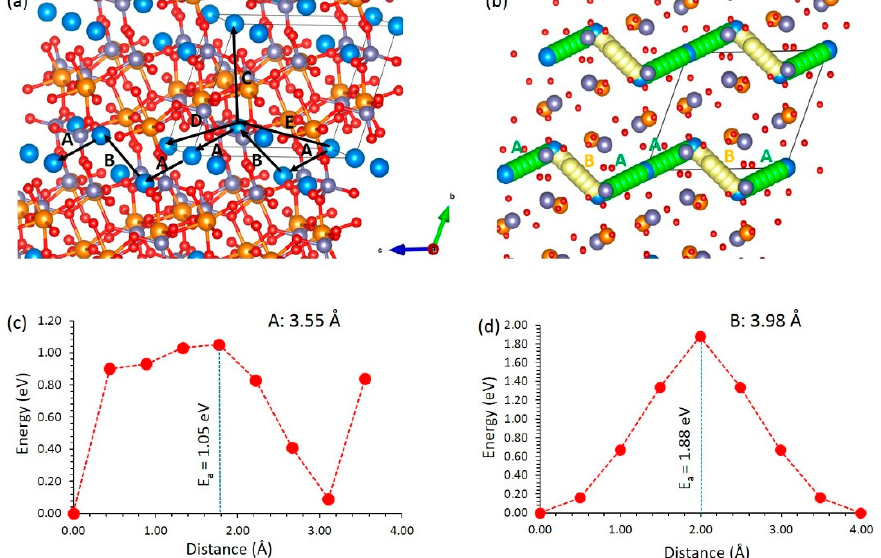
Figure 3. ( a ) Local Zn hops considered, ( b ) the most possible long-range diffusion pathway consisting of local hops A and B, ( c ) energy profile diagram showing the activation energy of the local hop A, and ( d ) similar diagram plotted for the local hop B. Table 4. Calculated activation energies of different Zn hops.